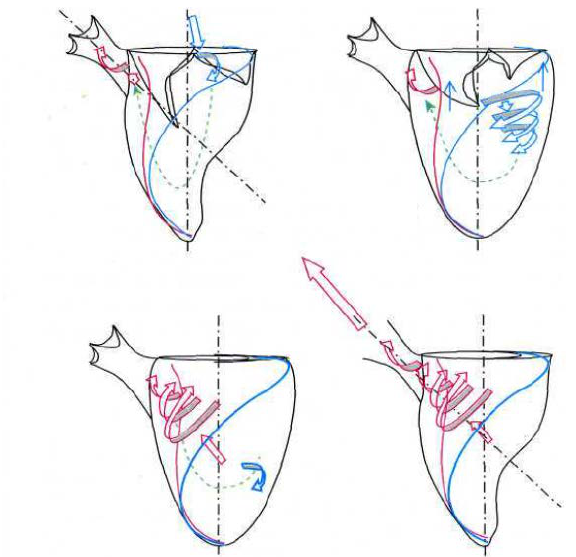
white - to the minimum zero